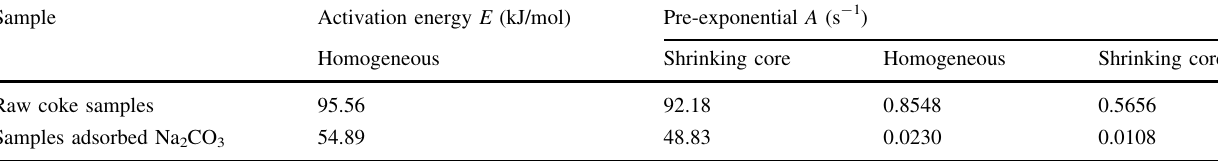
Table 2 Kinetic parameters of coke samples for the homogeneous model and the shrinking core model